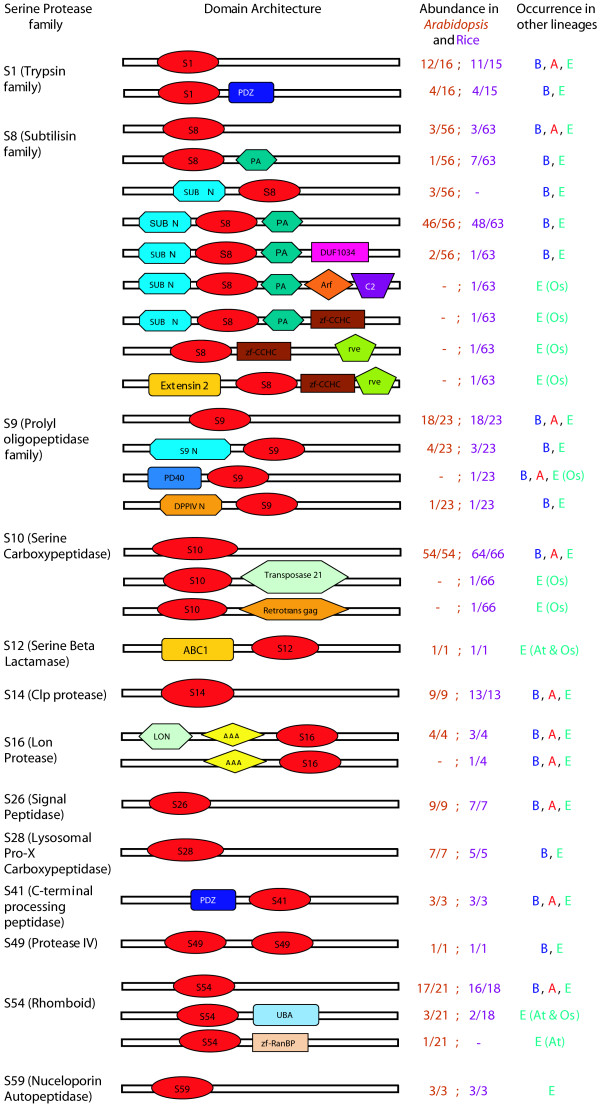
Domain Architectures identified in Arabidopsis and rice serine Protease-like proteins. At -Arabidopsis thaliana; Os – Rice (Oryza sativa); B- Bacteria; A- Archaea; E- Eukaryota; Sxx- Serine protease family Sxx domain, where Sxx refers to the serine protease family as per MEROPS [5] classification (see text for details). PDZ- PDZ domain (Pfam [37] accession: PF00595); PA- Protease associated domain (Pfam [37] accession: PF02225); SUB N- Subtilisin N-terminal region (Pfam [37] accession: PF005922); DUF1034- Domain of unknown function (Pfam [37] accession: PF06280); Arf- ADP-ribosylation factor family (Pfam [37] accession: PF00025); C2- C2 domain (Pfam [37] accession: PF00168); zf-CCHC- Zinc knuckle (Pfam [37] accession: PF00098); rve- Integrase core domain (Pfam accession:PF00665); Extensin 2- Extensin-like region (Pfam [37] accession: PF04554); S9 N- Prolyl oligopeptidase, N-terminal beta-propeller domain (Pfam [37] accession: PF02897); PD40- WD40-like beta propeller repeat (Pfam [37] accession: PF07676); DPPIV N- Dipeptidyl peptidase (DPP IV) N-terminal region (Pfam [37] accession: PF00930); Transposase 21- Transposase family tnp2 (Pfam [37] accession: PF02992); Retrotrans gag- Retrotransposon gag protein (Pfam [37] accession: PF03732); ABC1- ABC1 family (Pfam [37] accession: PF03109); LON- ATP-dependent protease La (LON) domain (Pfam [37] accession: PF02190); AAA- ATPase family associated with various cellular activities (Pfam [37] accession: PF00004); UBA- UBA/TN-S (ubiquitin associated) domain (Pfam [37] accession: PF000627); zf-RanBP- Zinc finger in Ran binding protein and others (Pfam [37] accession: PF00641).